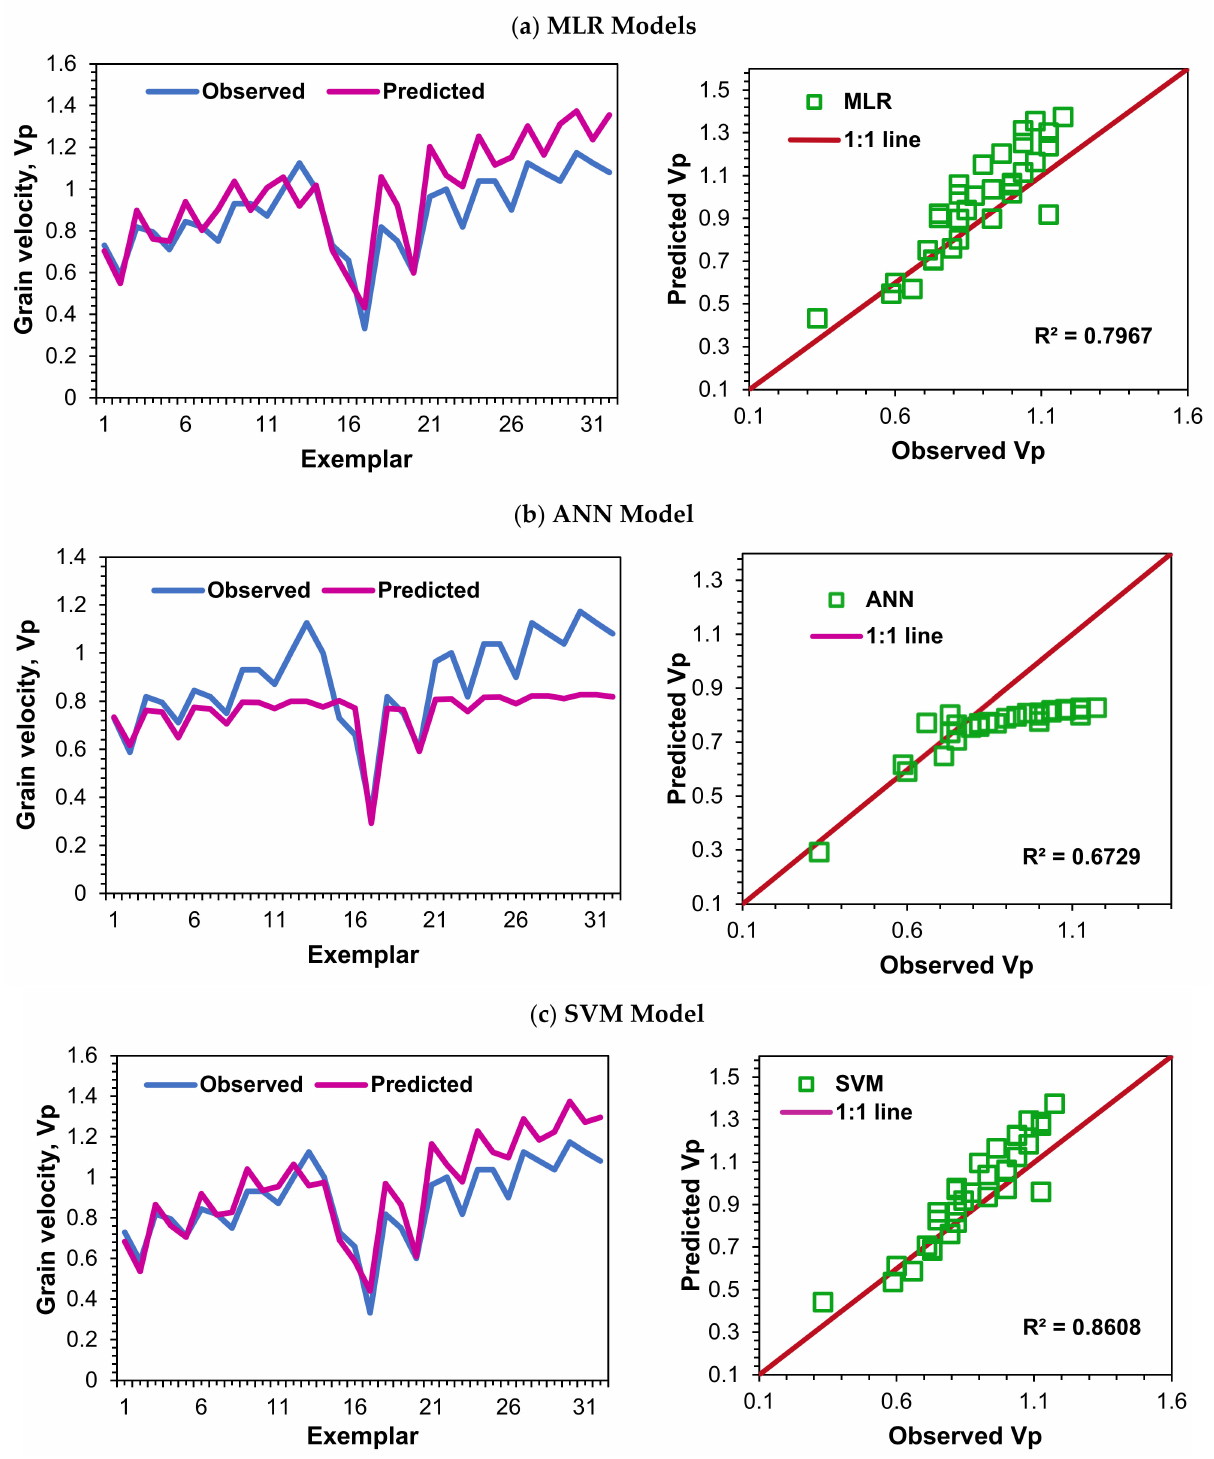
Figure 5. Observed versus predicted grain velocity by the ( a ) MLR, ( b ) ANN, and ( c ) SVM models during the testing